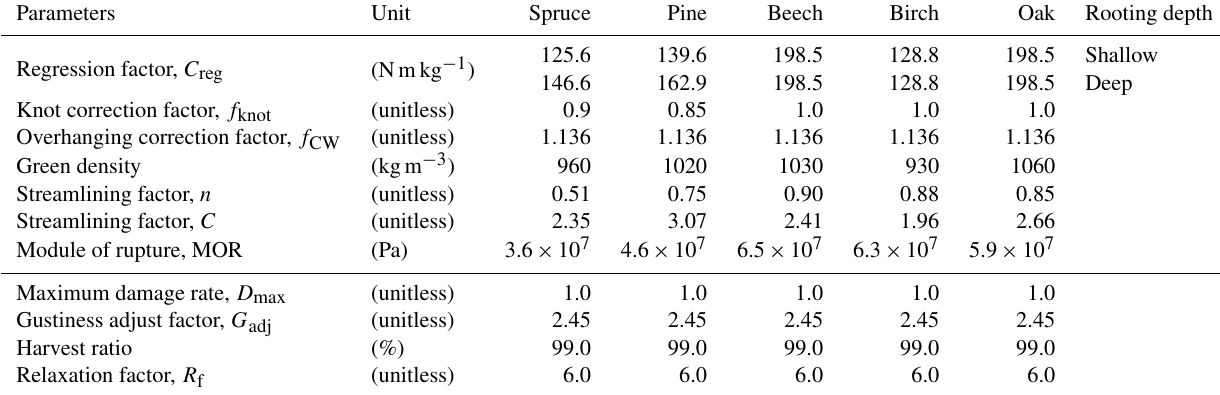
Table 2. Parameter values used in the ORCHIDEE-CAN wind-throw module. The scientific names of the tree species are given in Sect. 2.3.2. Parameters Unit Spruce Pine Beech Birch Oak Rooting depth Regression factor, C reg (Nmkg − 1 ) Knot correction factor, f knot Overhanging correction factor, f CW Green